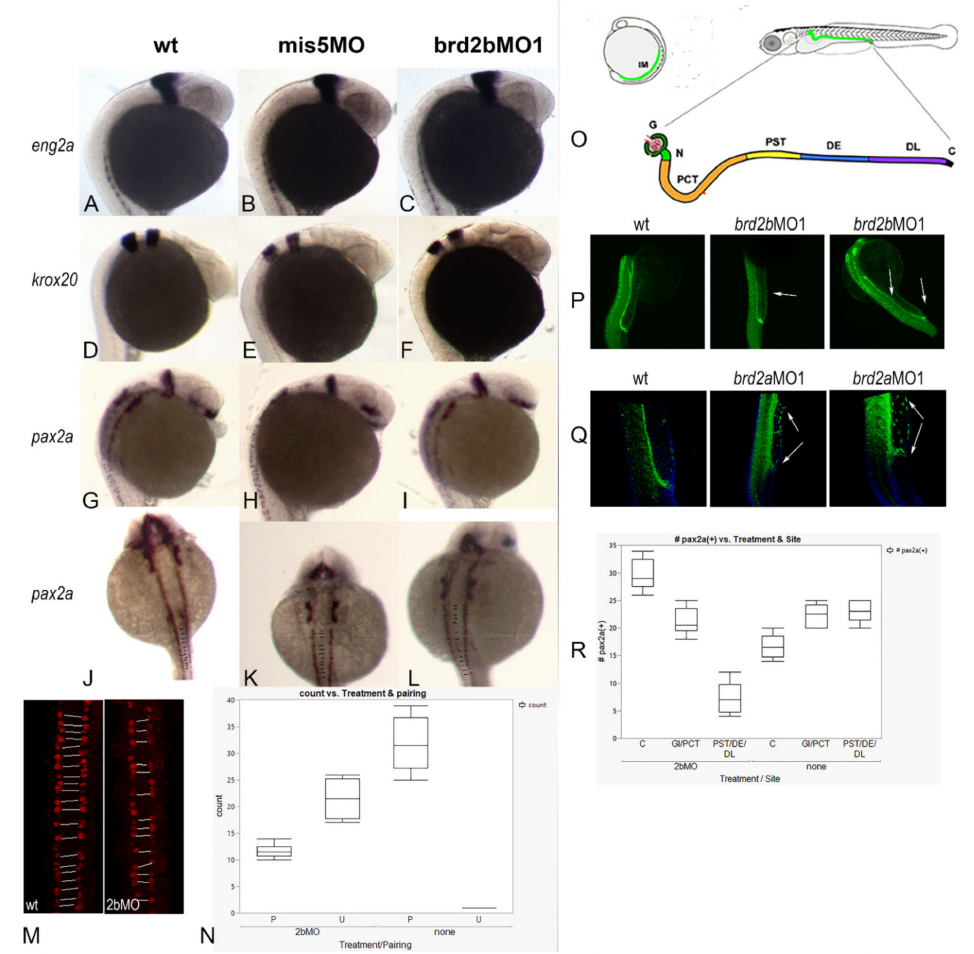
Figure 6. MHB expression of pax2a, eng2a and krox20 mRNA is normal, but patterning of pax2a (+) spinal interneurons and pronephric cells is disrupted, in brd2b morphants. Panels ( A – L ): Brightfield images of representative 24 hpf prim5 control and morphant embryos assayed by In situ hybridization for expression of patterning genes at the MHB region ( A – I ) and in spinal interneurons ( J – L ). Uninjected embryos (wt; A , D , G , J ), embryos injected with control brd2b -5-base mismatch morpholino (mis5MO; B , E , H , K ), and embryos injected with brd2b MO (brd2bMO1; C , F , I , L ) were assayed for eng2a ( A , B , C ), krox20 ( D , E , F ,), and pax2a ( G , H , I ; J , K , L ) expression. No differences in patterning gene expression at the MHB region are detected. Using pax2a (+) as a marker for spinal interneurons reveals mispairing on either side of the midline in morphants ( J , K vs. L , gaps between lines). ( M ) Immunofluorescence with anti-Pax2a antibodies to visualize interneurons on either side of spinal cord, dorsal views of maximum projection confocal images. Representative control uninjected (wt) and brd2b MO1-injected (2bMO) embryos are shown with symmetrically paired interneurons linked by white lines; unpaired interneurons appear solo on one side of the central spinal cord. ( N ) The number of paired “P” vs. unpaired “U” interneurons in six embryos per treatment group (uninjected controls = none; brd2b MO-injected = 2bMO) was analyzed by chi-square contingency and is shown as a box plot ( p < 0.0001). While, on average, only 3% of interneurons are unpaired in wild type, about 65% are unpaired in brd2b MO morphants. Panels O – R: Analysis of Pax2a(+) pronephric precursor cells in the developing duct in brd2b MO and brd2a MO morphants by quantitative immunofluorescence. ( O ) Diagram of pronephric duct segments: G, glomerulus; N, neck; PCT, proximal convoluted tube; PST, proximal straight tube; DE, distal early tube; DL, distal late tube; C, cloaca. ( P ) Pax2a(+) immunofluorescence in uninjected (wt) and brd2b MO morphants ( brd2b MO1). ( Q ) Pax2a(+) immunofluorescence in uninjected (wt) and brd2a morphants ( brd2a MO1). Paralogs show opposite effects on distribution of Pax2a(+) pronephric cells (arrows). brd2b morphants show fewer cells in the more distal parts of the tube (PST, DE, DL) but more cells at the very end cloaca (C), compared to wild type, while brd2a morphants show excess cells along the tube, and a normal number of cells at the cloaca. ( R ) Quantitation of distribution of Pax2a(+) cells in uninjected (none) and brd2b MO1-injected embryos (2bMO), by pronephric segment. Boxplot of ANOVA and paired t -tests shows significant differences in the predicted direction between these two treatment groups in segments PST/DE/DL ( p < 0.0001,) and in C ( p < 0.0001), but not in G/PCT ( p =